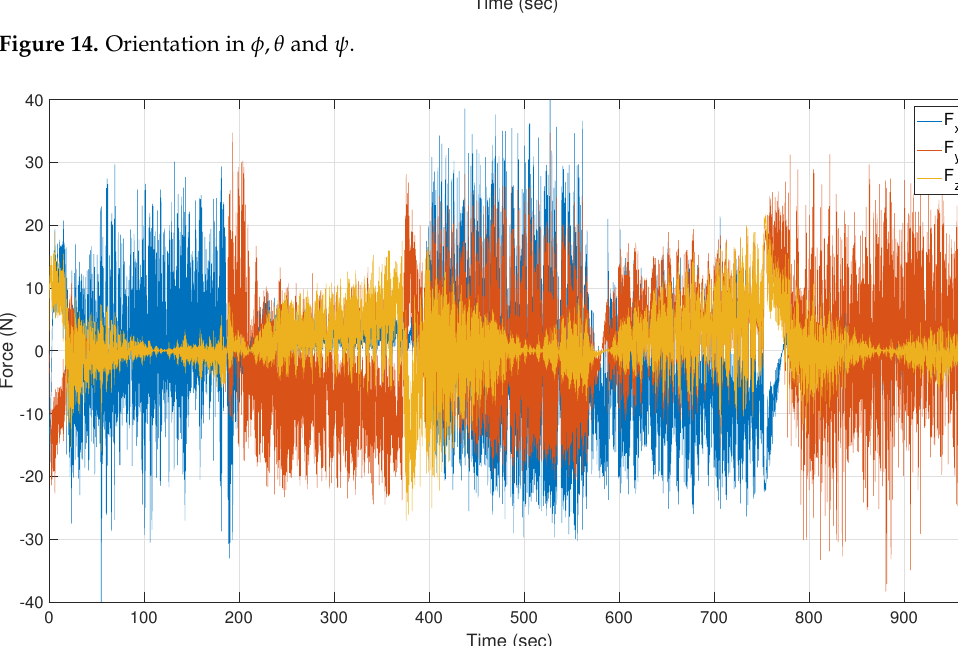
Figure 15. Tether force in x,y and